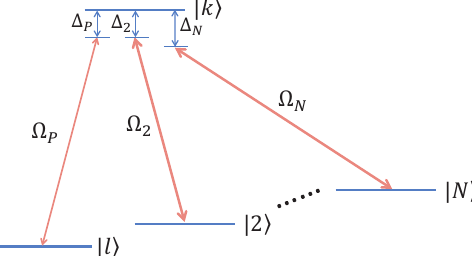
Figure 1. Schematic diagram of the N + 1 level atomic system. The upper level state is labeled | k (cid:105) , and the lower level states are labeled | l (cid:105) , | 2 (cid:105) , . . . | N (cid:105) . The energy levels are coupled by N coherent laser fields on each upper-lower pair. The corresponding Rabi frequencies and field detunings of the coupling fields are Ω p , Ω 2 , . . . Ω N and ∆ p , ∆ 2 , . . . ∆ N .